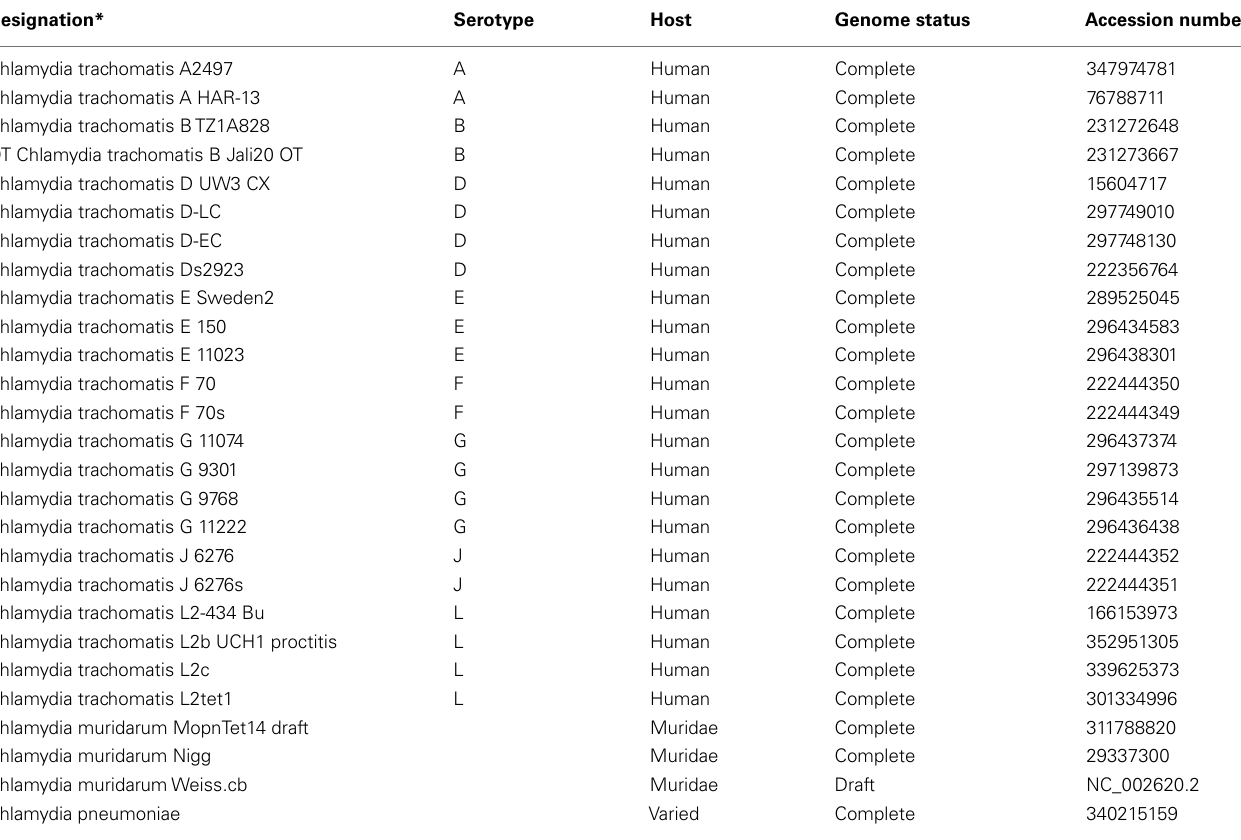
TableA3 | Genomes used for assessment of functional genome distribution on strain